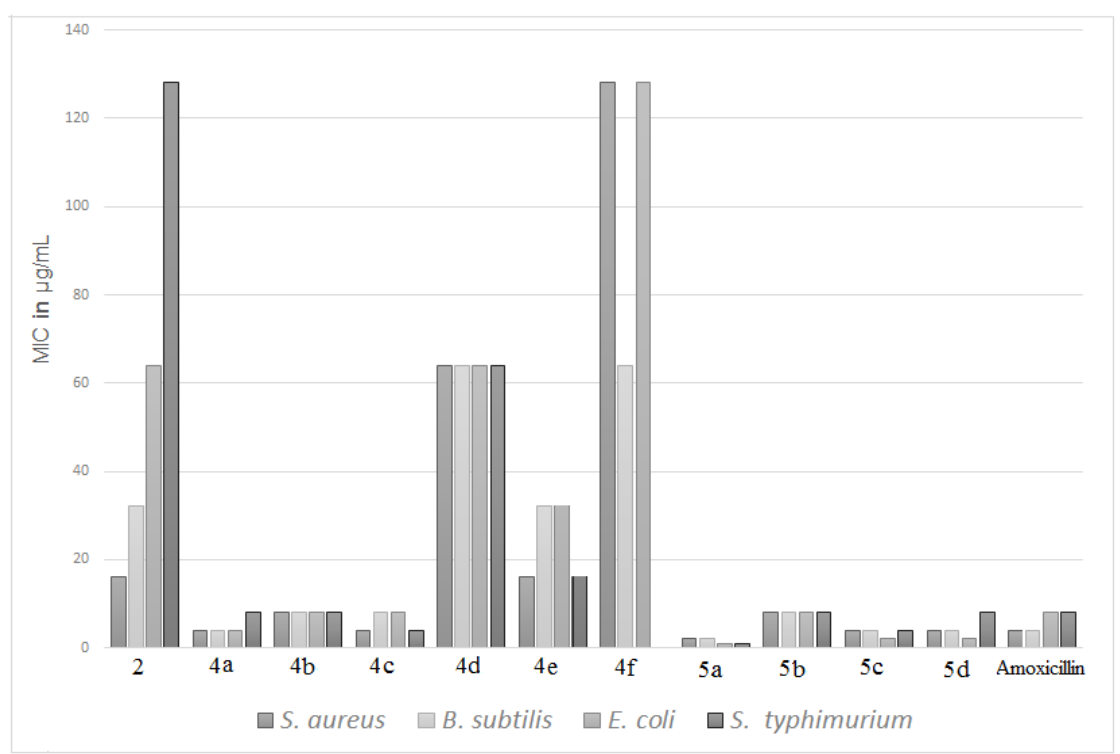
Figure 2. The antibacterial activity (MIC in μg/mL) of the of the synthesized quinazolin-4(3 H )one derivatives compared with Amoxicillin trihyderate.